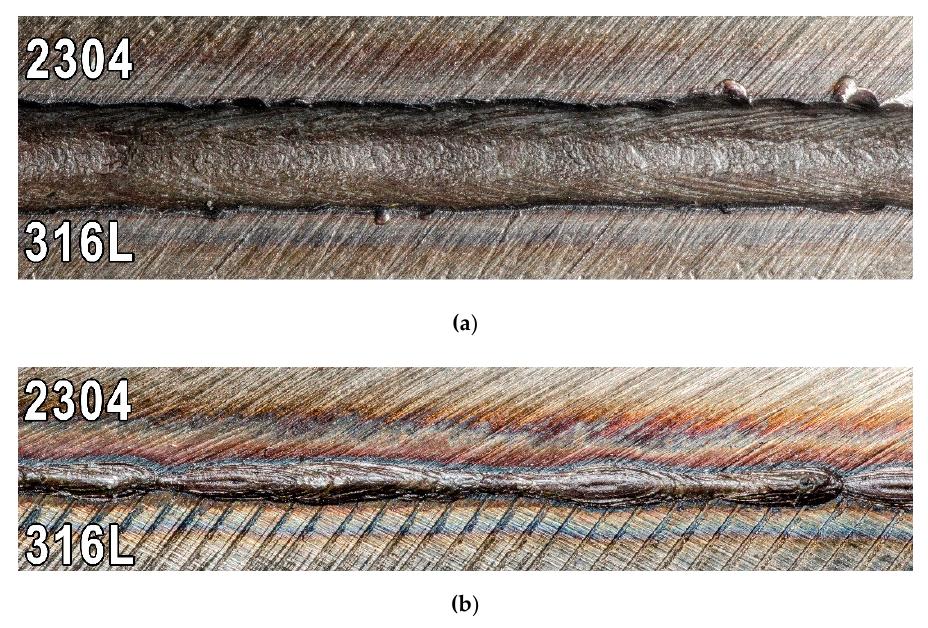
Figure 2. View of the welded joint: ( a ) face side and ( b ) root side.